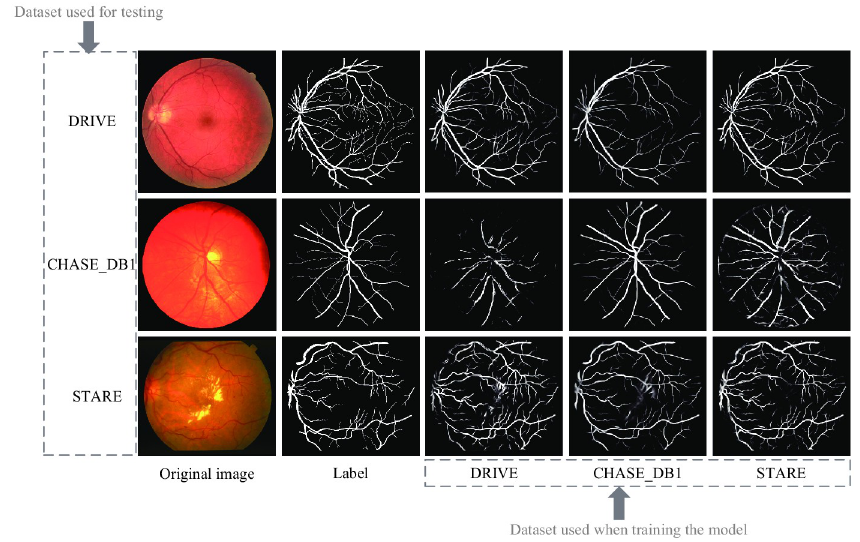
Fig 9. Segmentation result of cross-validate experiment. The first column is the original image; The third to fifth columns are the results of segmenting the three data sets using the model files trained on DRIVE, CHASE DB1 and STARE by MFI-Net.